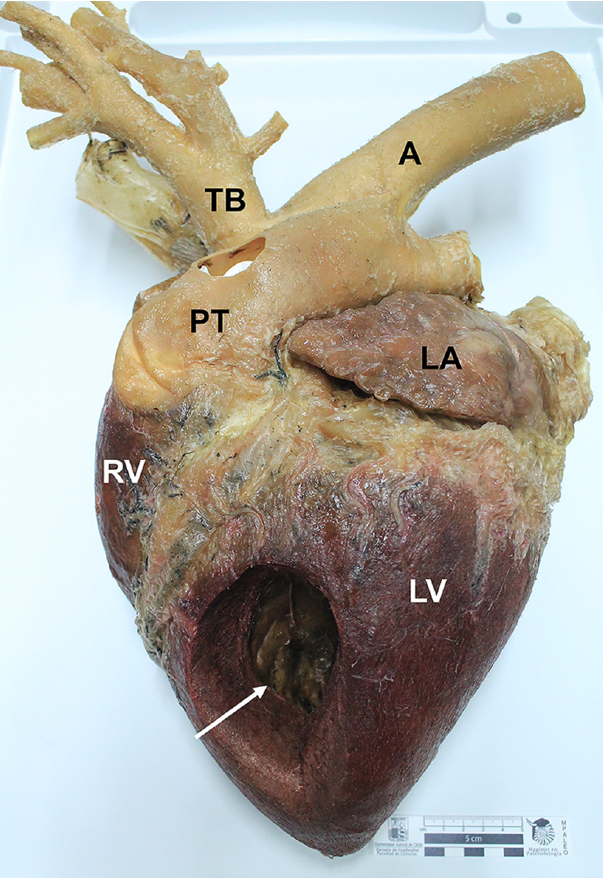
Figure 1. Photograph of the left side of an equine heart ( facies auricularis ) preserved and stained by the modified Elnady technique. A window opening in the left ventricle (white arrow). A: Aorta; LA: Left auricle; TB: Brachiocephalic trunk; PT: Pulmonary trunk; LV: Left ventricle; RV: Right ventricle. Red color in the ventricles is clearly observed in the organ.